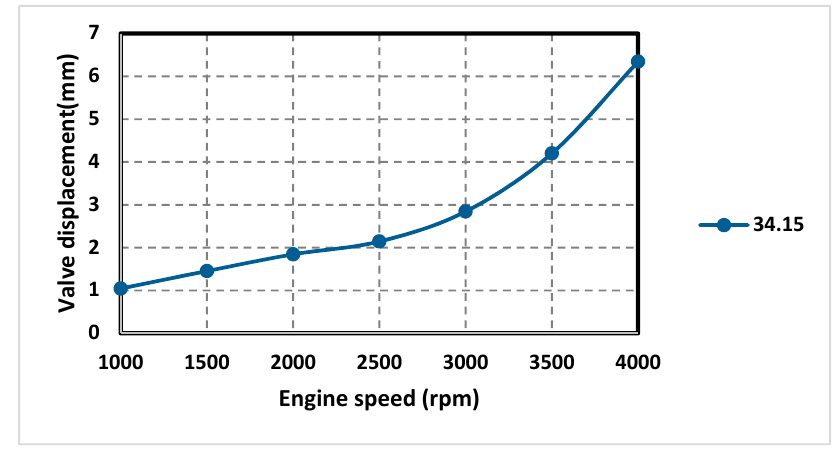
Figure 22. The relationship between the engine speed and valve displacement.